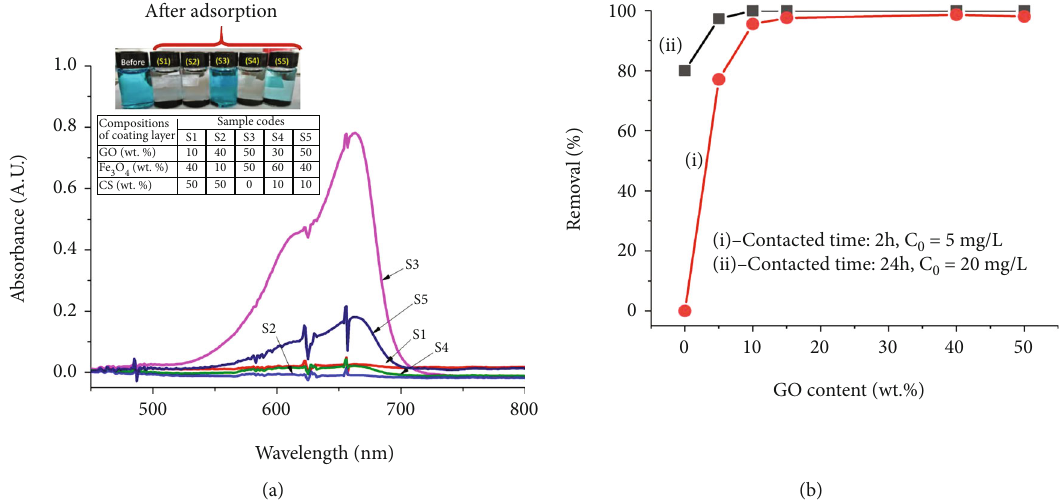
Figure 5: (a) UV-Vis spectra of samples after adsorption of MB solutions (inserted images are the colors of the MB solutions before and after adsorption onto GO/Fe O /CS [percent by weight, wt.%]: S1 [50 :40 :10], S2 [50 :10 :40], S3 [0 :50 :50], S4 [10 :60 :30], and 3 4